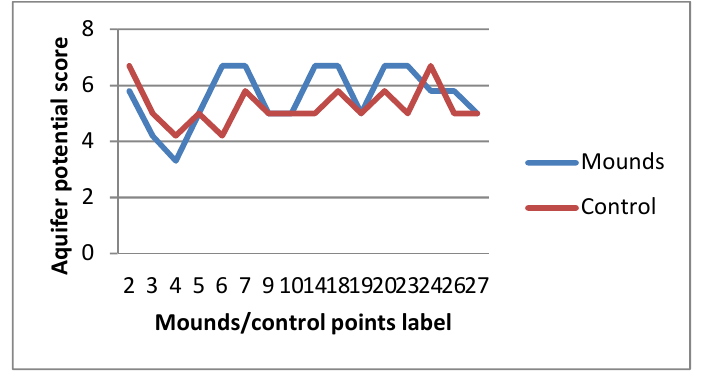
Figure 7. Aquifer potential around Macrotermes mounds and control areas.